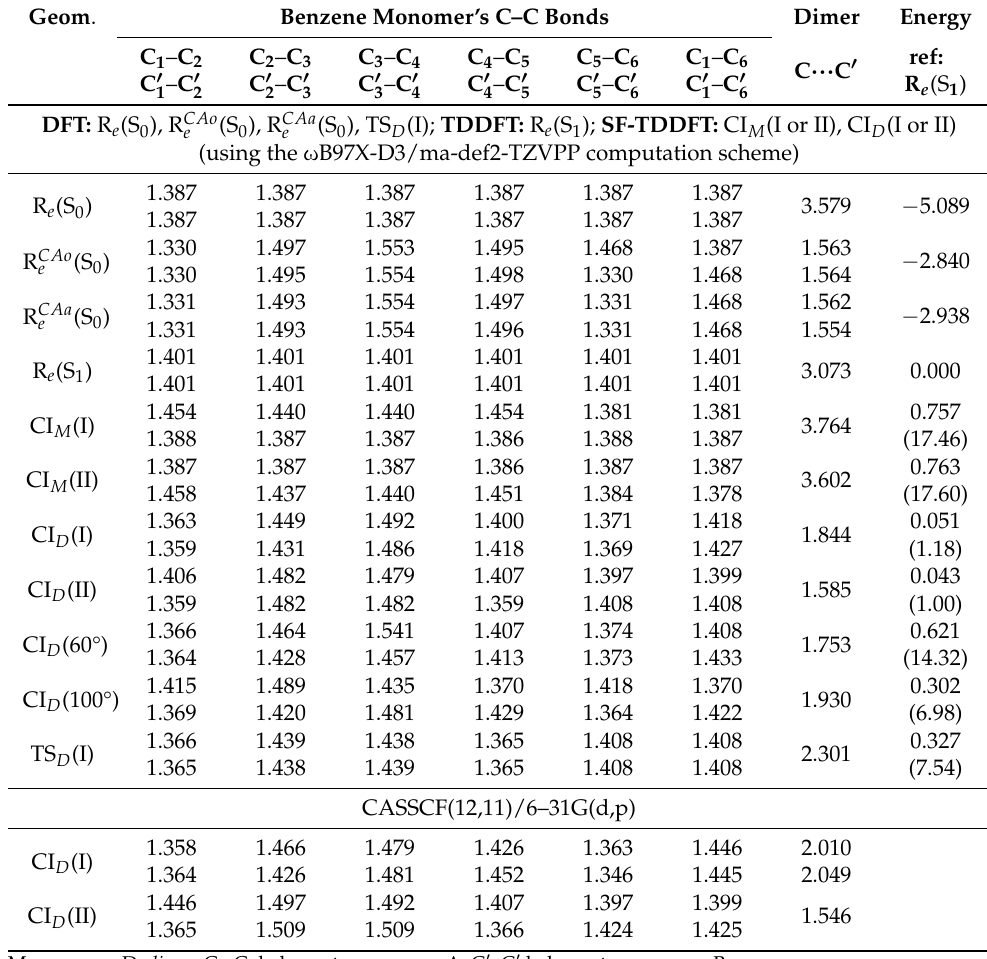
Figure 1. Equilibrium geometry structures of benzene dimer computed for ground ( a ) and first electronic excited ( b ) state considering the ω B97X-D3/ma-def2-TZVPP computation scheme at DFT and TDDFT levels of theory, respectively. Table 1. The bond lengths between the carbon atoms (in Å) and the conformational energy differences (last column) considering the first excited-state equilibrium structure as reference geometry (in eV and in kcal/mol in parenthesis) of benzene dimer computed for different equilibrium (R e ) and S 0 /S 1 conical intersection (CI) geometries at DFT, TDDFT, SF-TDDFT and CASSCF levels of theory. The XYZ coordinates of each geometry structure are listed (L1) in the Supplementary Material file. Geom